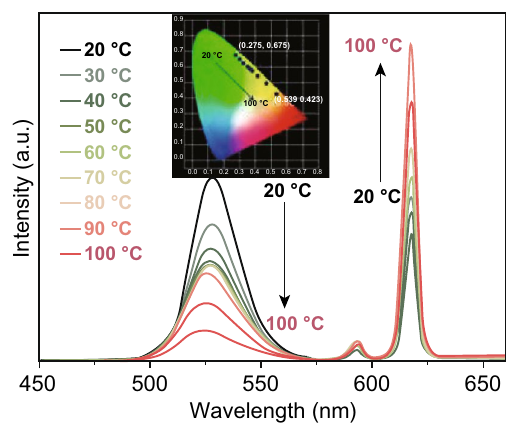
Fig. 25 Temperature-dependent PL spectra of CsPbBr 3 @Eu-BTC in the temperature range of 20–100 °C excited at 339 nm (inset: the CIE ( x , y ) coordinate diagram of emission colors at various